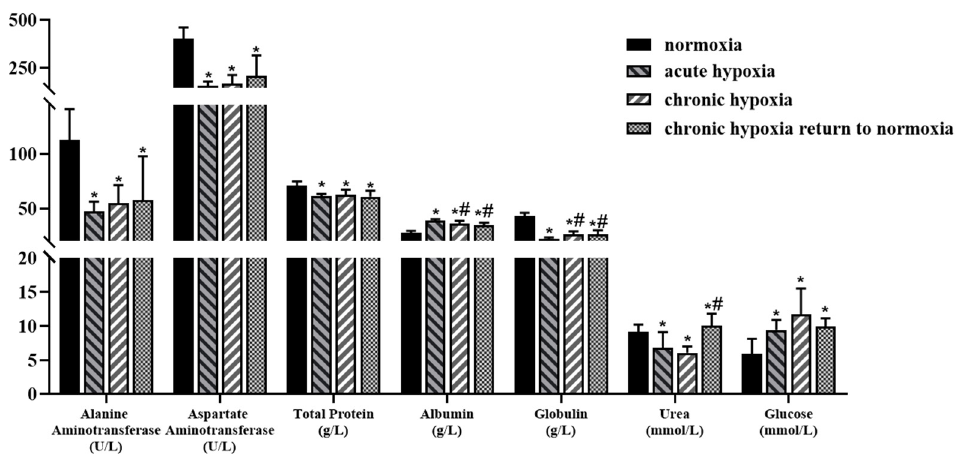
Figure 2. Changes in alanine aminotransferase, aspartate aminotransferase, total protein, albumin, globulin, urea, and glucose in rats after exposure to high-altitude hypoxia. The data are presented as mean ± SD. n = 8. * p < 0.05 compared to the normoxia group; # p < 0.05 compared to the acute hypoxia group; △ p < 0.05 compared to the chronic hypoxia group.